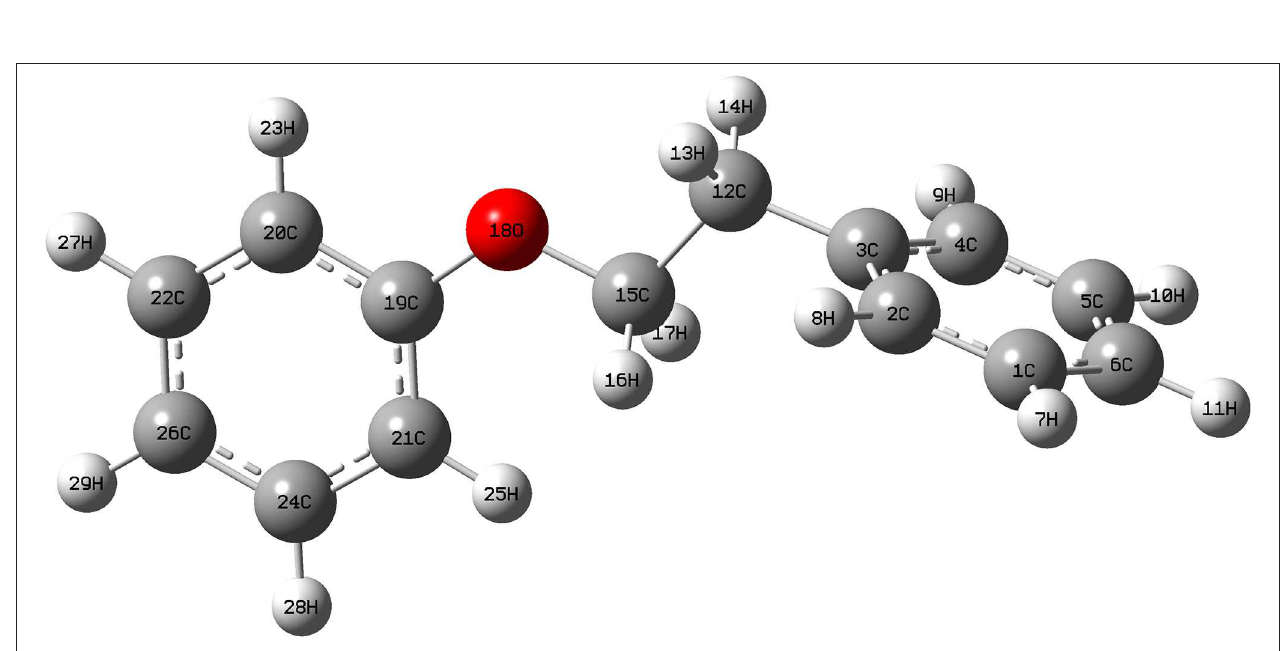
FIGURE 3 | Model structure of